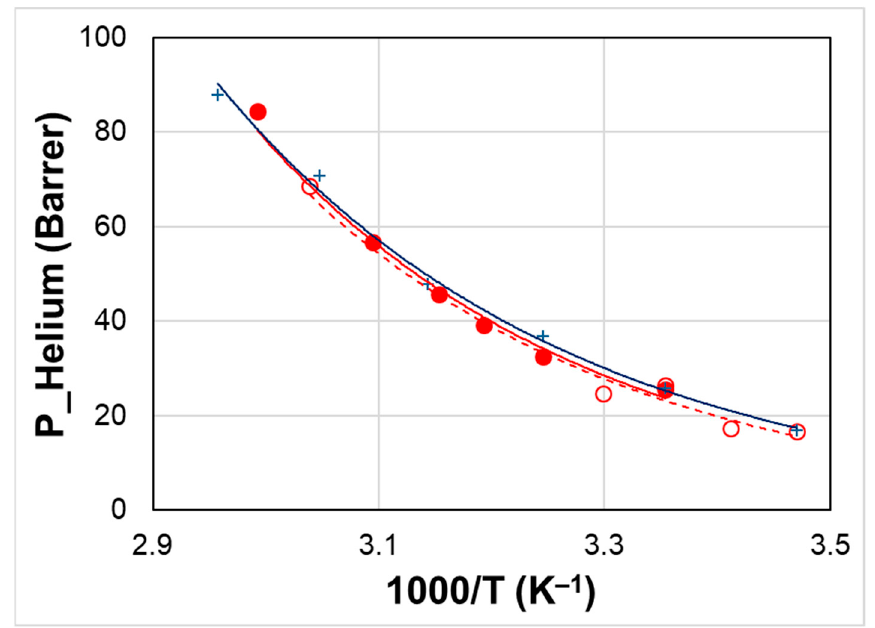
Figure 12. Temperature effect on Helium permeability for Rnew (plus sign, +) and Rnew–10% IL1 (HdmimDMSIP) composite membranes (circle). Closed symbols: heating; open symbols: cooling.